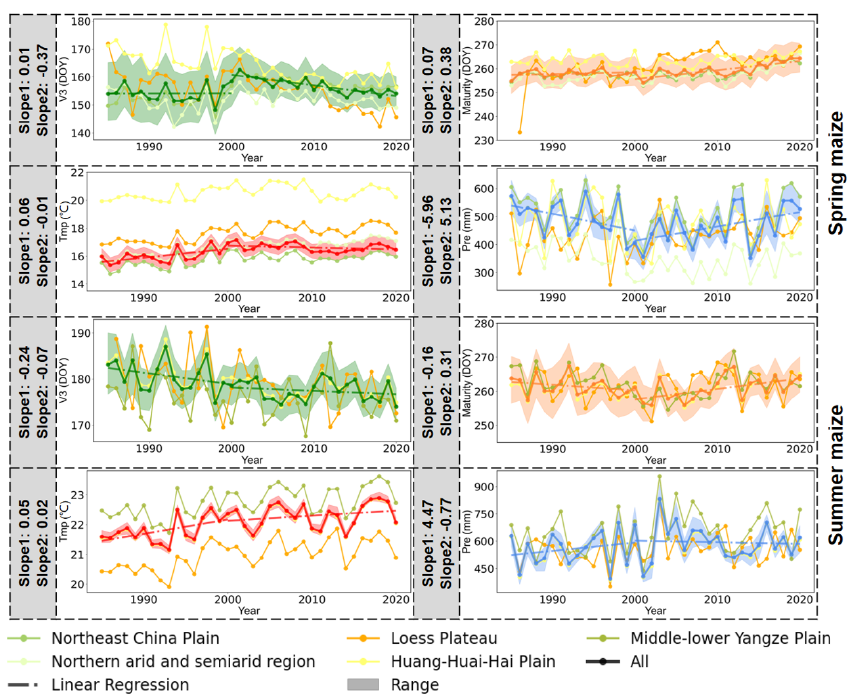
Figure 14. Temporal trends of phenological indicators (i.e., v3, maturity) and climate variables (i.e., mean temperature and mean total precipitation) during the growing period (from May to October), from 1985 to 2020. Two segments (i.e., 1985–2000 and 2001–2020) were independently fitted due to their distinct difference in temporal trends. We provide the temporal trend of variables across the study area and the interannual variations within different major agricultural